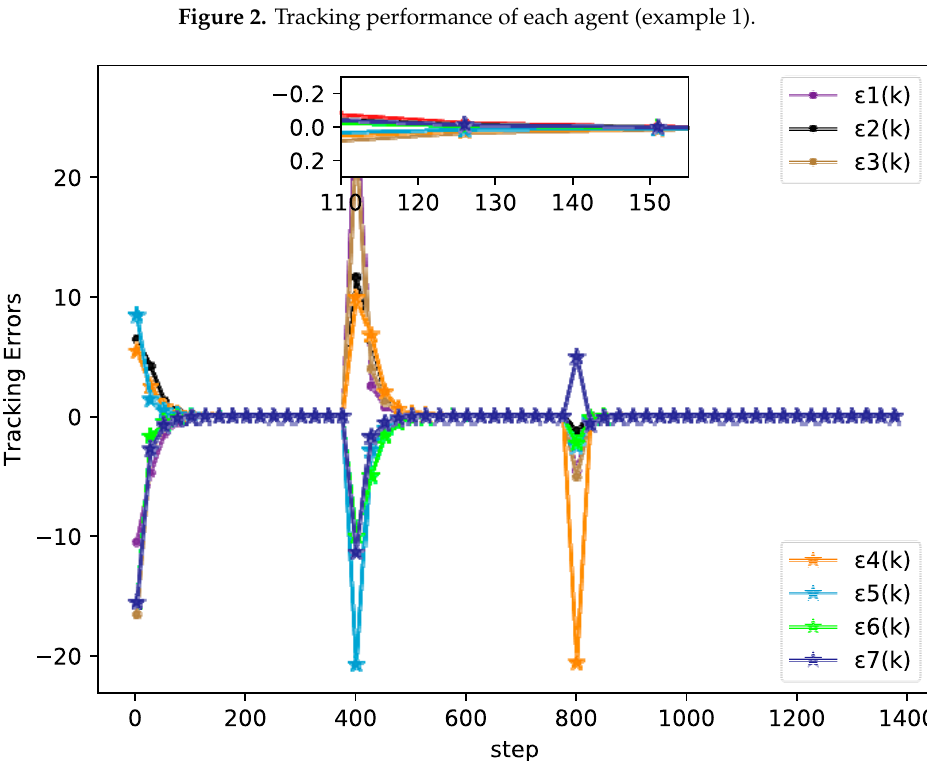
Figure 3. Tracking errors of each agent (example 1).